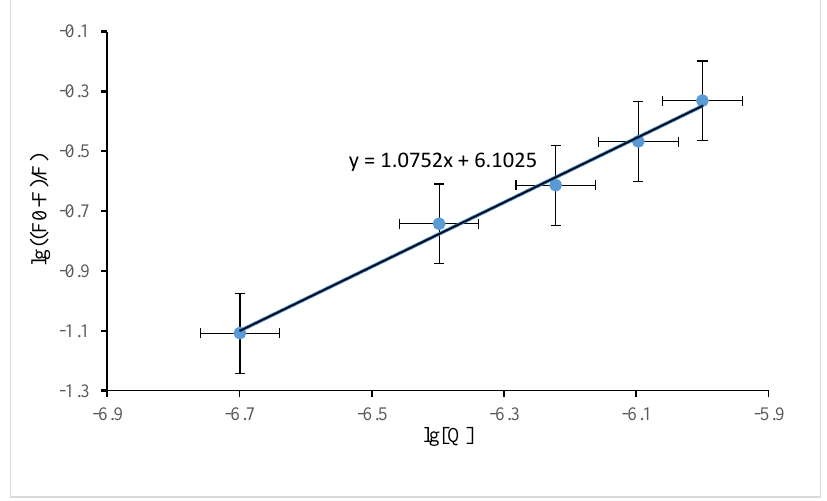
Figure 4. Double logarithm quenching plot for anti − Dechlorane plus and sheep serum albumin.